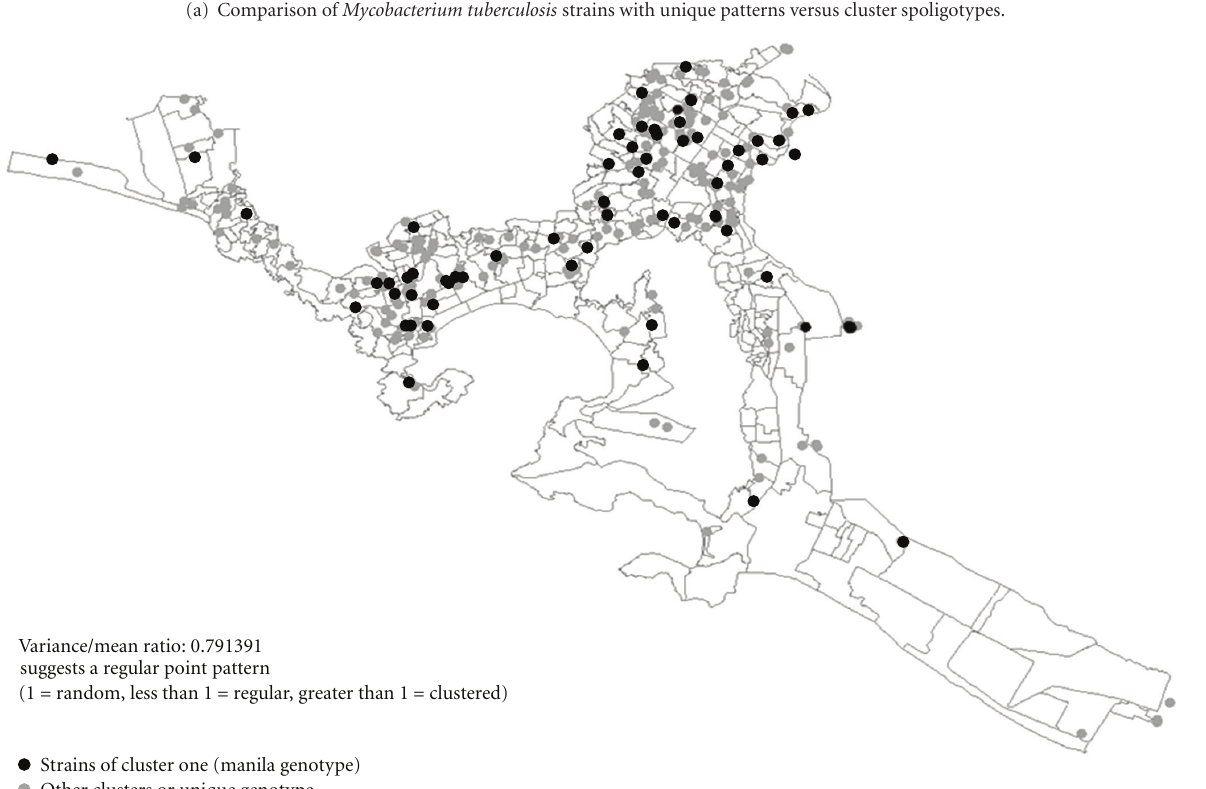
Figure 2: Geographical distribution of tuberculosis cases in Acapulco, Mexico. Mapping and georeferencing of tuberculosis cases used a scale of 1: 50000. Point cluster analysis relied on the IDRISI QUADRAT module. The variance/mean ratio significantly smaller than 1.0 suggests a regular distribution, while values greater than 1.0 suggest spatial